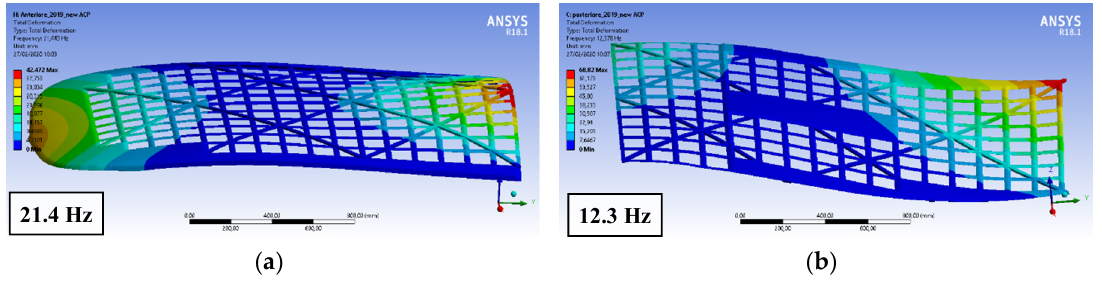
Figure 7. Numerical modal analysis of ( a ) front, ( b ) back section of the roof.